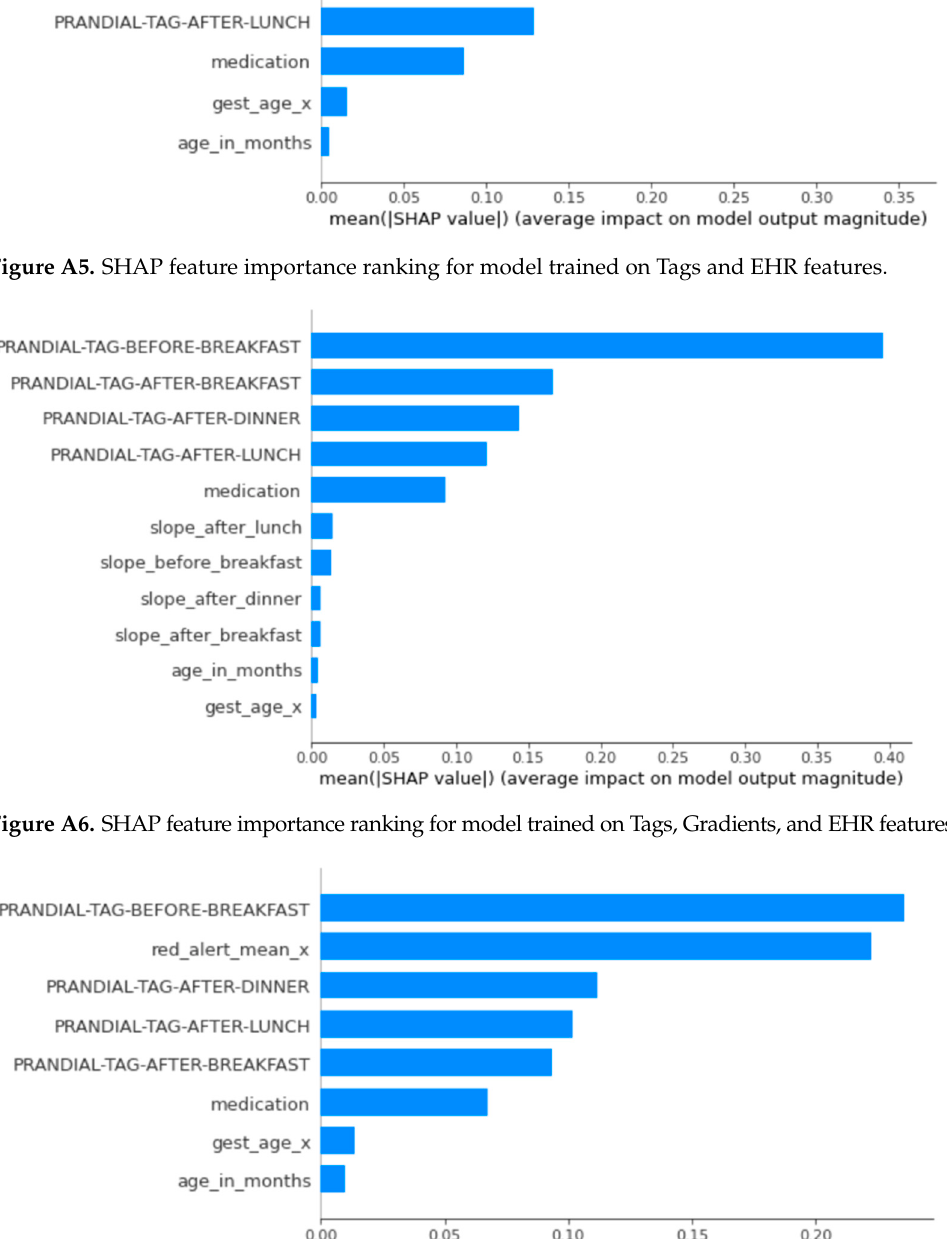
Figure A7. SHAP feature importance ranking for model trained on Tags, High-Readings, and EHR features.